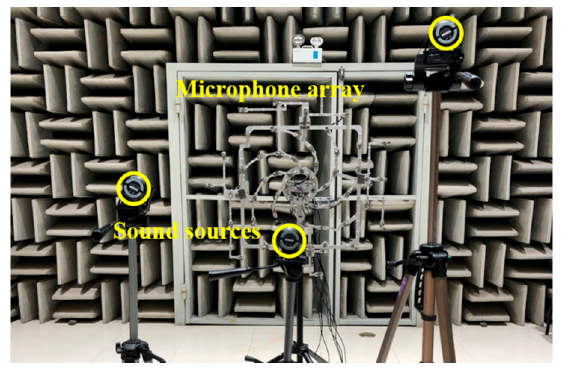
Figure 12. Experimental setup: three loudspeakers and the spiral microphone array in a semi- anechoic chamber.